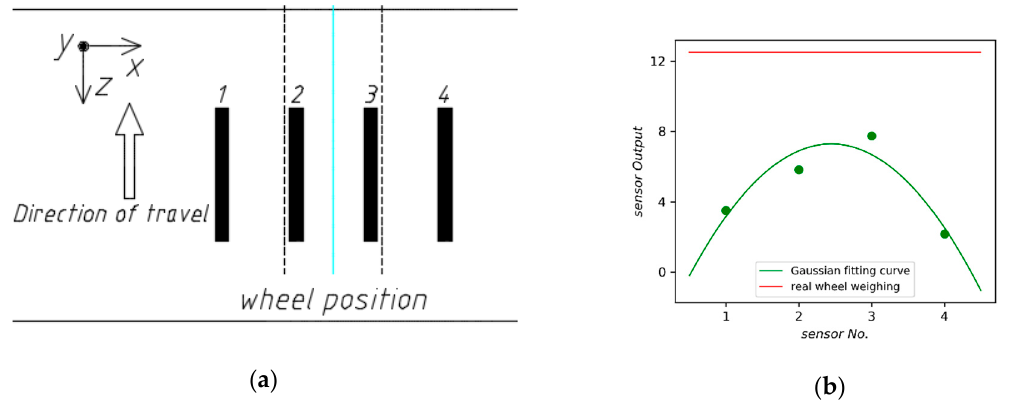
Figure 22. ( a ) The array with four longitudinal sensors; ( b ) Gaussian fitting curve.